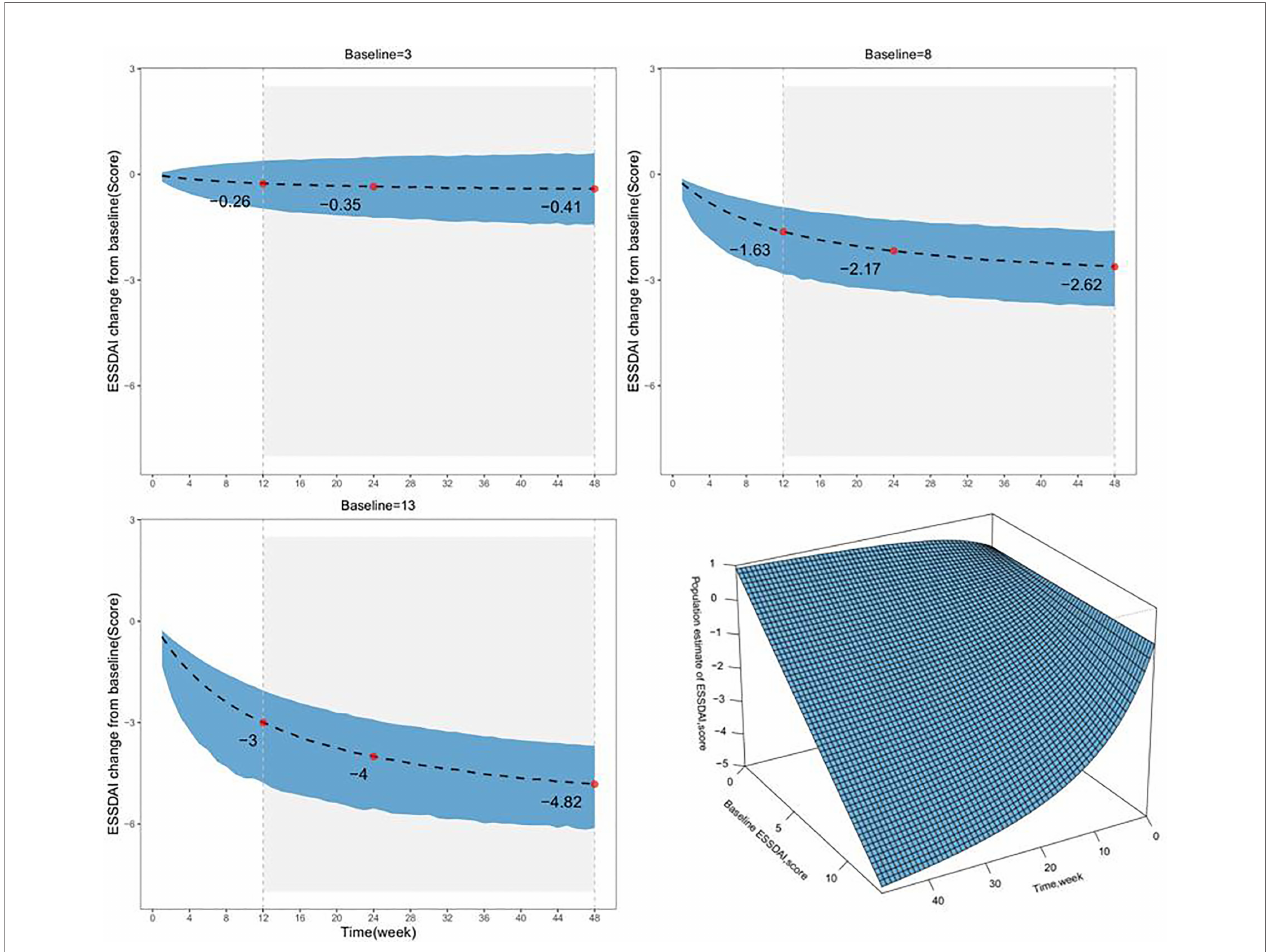
FIGURE 3 | The model-estimated typical placebo time-response under different baseline levels. The dotted lines represent the typical ef fi cacy, and the shaded areas are their 95% CIs. The points represent the estimated values of the placebo response. The lower right, a surface plot to describe the relationship among time, Baseline ESSDAI score, and the ESSDAI score. Patients with longer treatment duration and higher baseline ESSDAI score were predicted to manifest more ESSDAI score decline and better symptom relief.